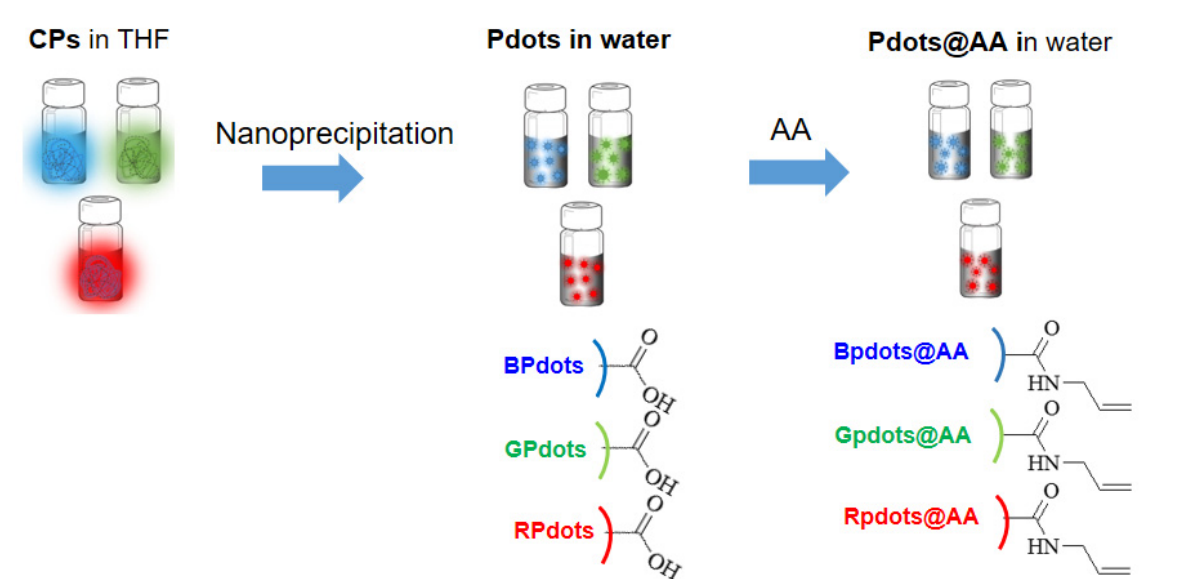
6 of 12 Figure 1. ( a ) UV-vis and ( b ) fluorescence spectra of CP films. 3.2. Preparation of Polymer Nanoparticle Coated with Allyl Amine